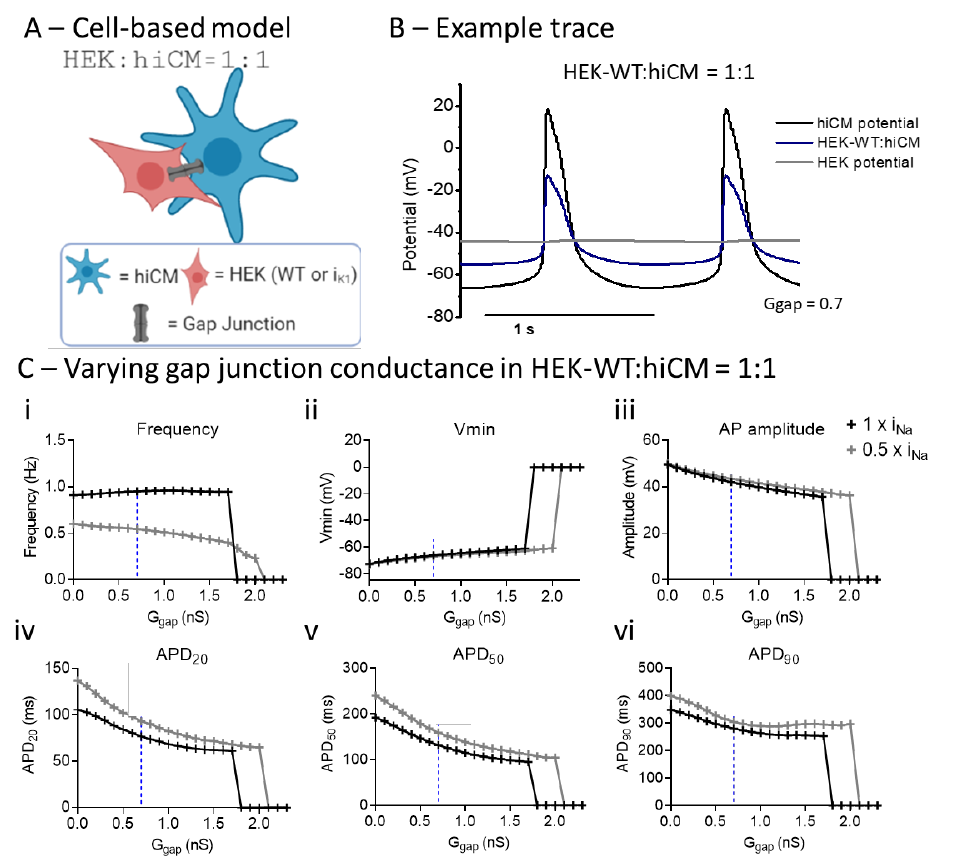
Figure 5. Computational modeling shows the effects of varying gap junction conductance (G gap ) in a co-culture of hiCM with HEK–WT, and different Na + channel expression. ( A ) Diagram of HEK:hiCM interaction used for computational model. ( B ) Example trace showing hiCM potential, HEK potential, and the average of the two. ( C ) Varying G gap effects on frequency of spontaneous beating, hiCM’s Vmin, amplitude and APD. Simulations were done in regular I Na (1 × I Na ) and when only half (0.5 × I Na ) was present.